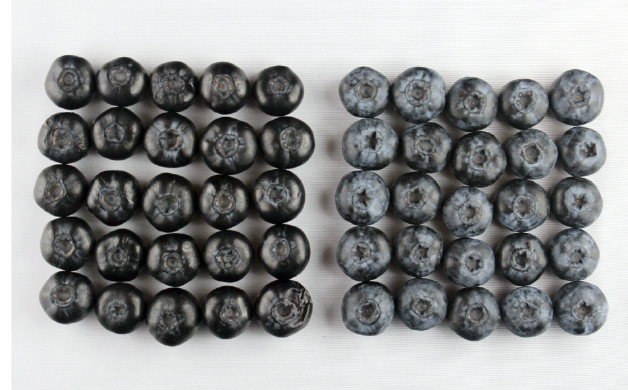
Fig. 1: Blueberries with their natural wax surface (right) and after polishing (left) as employed for the present study.